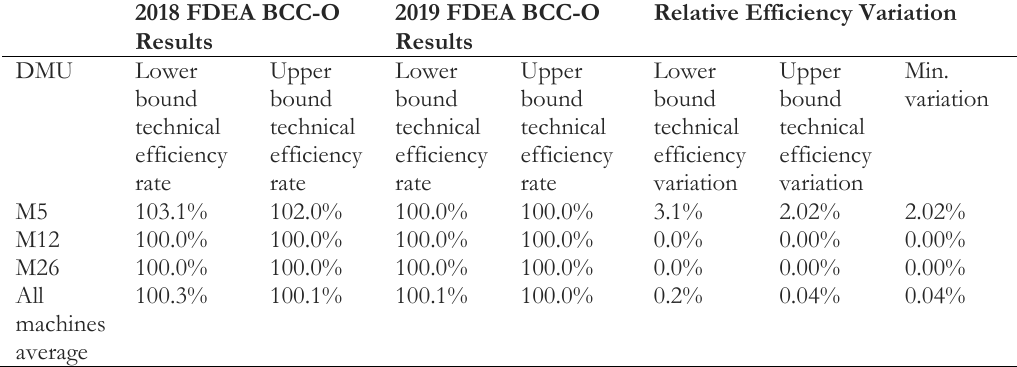
Table 9. BCC – output-oriented classical DEA results and efficiency